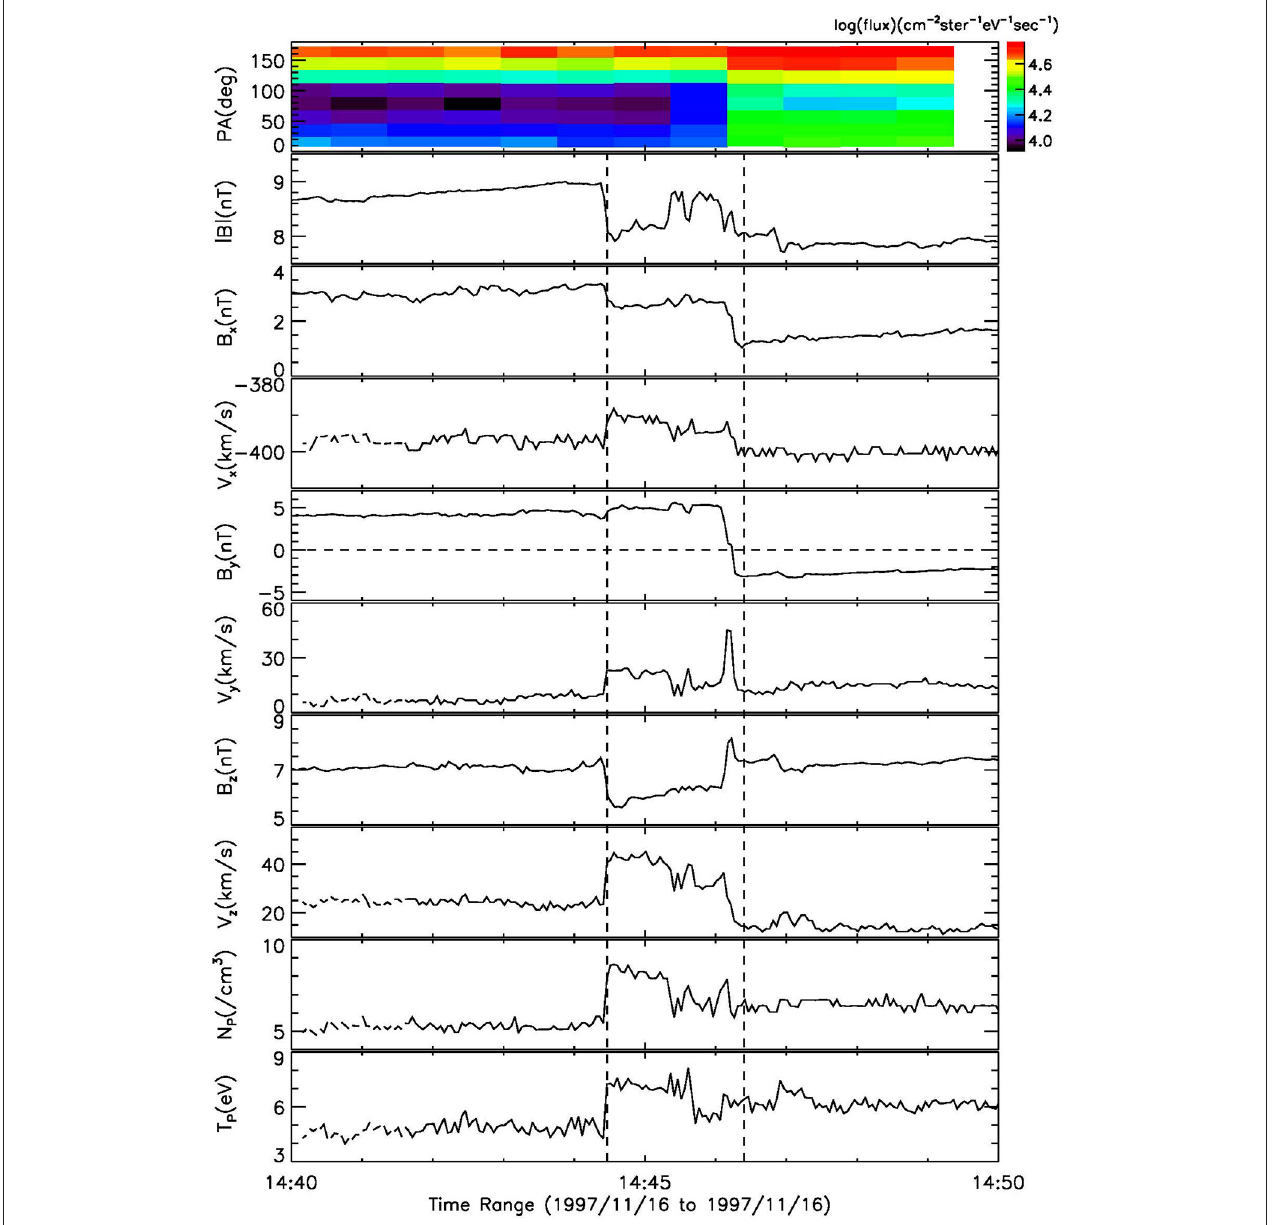
FIGURE 2 | Magnified images of the suprathermal electron distributions, magnetic field, and plasma data of the reconnection exhaust around 14:45 UT November 16th measured by Wind. The two vertical dashed lines denote the reconnection exhaust